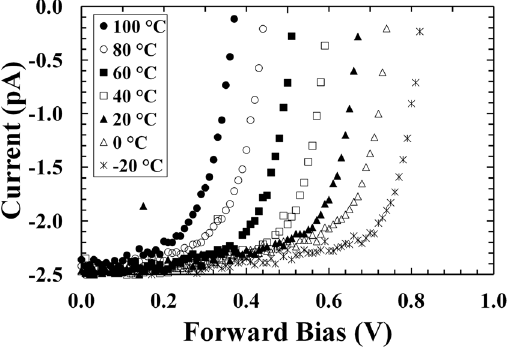
Figure 4. Current as a function of applied forward bias for 55 Fe X-ray photovoltaic In 0.5 Ga 0.5 P cell. The temperatures studied were 100 °C (filled circles), 80 °C (empty circles), 60 °C (filled squares), 40 °C (empty squares), 20 °C (filled triangles), 0 °C (empty triangles), and − 20 °C (stars).